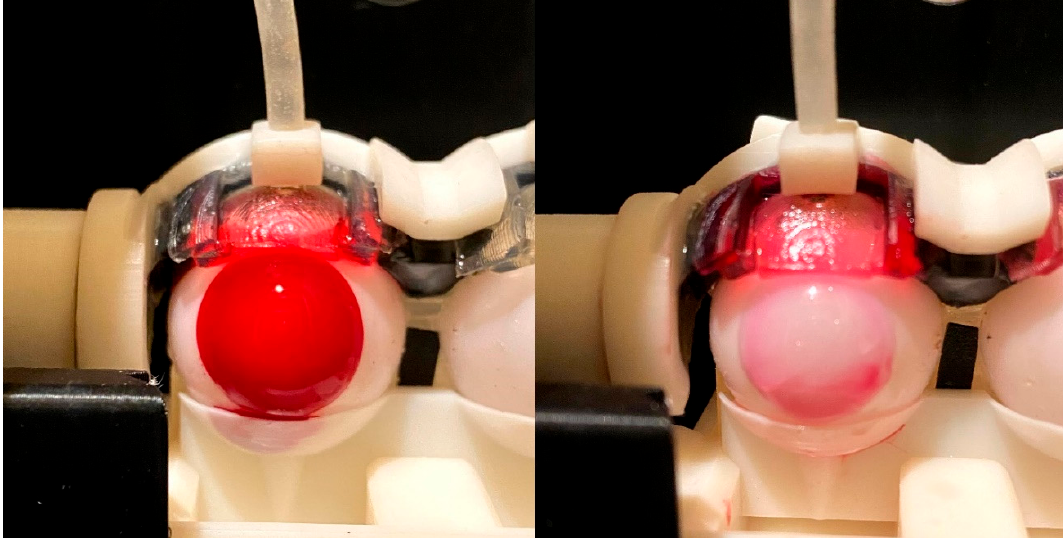
Figure 6. Representative images of etafilcon A at 0 and 24 h on the eye model.